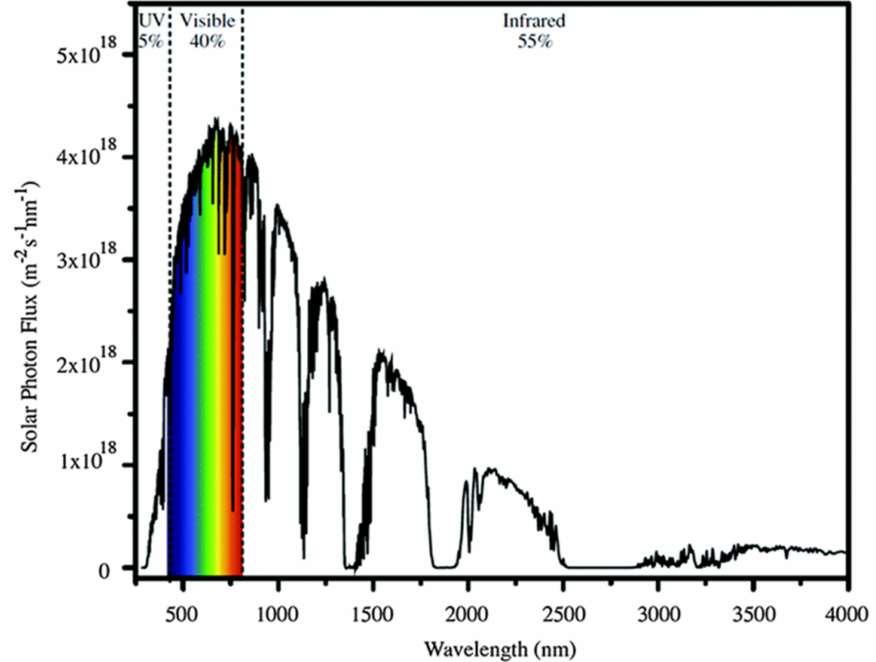
Figure 10. Sunlight emission spectra. Reproduced with permission from